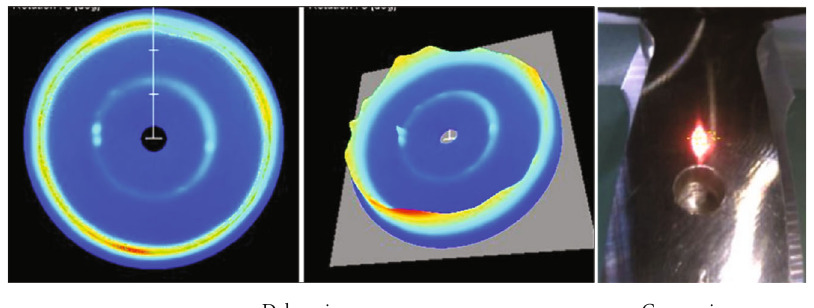
Figure 17: Debye ring and measured physical